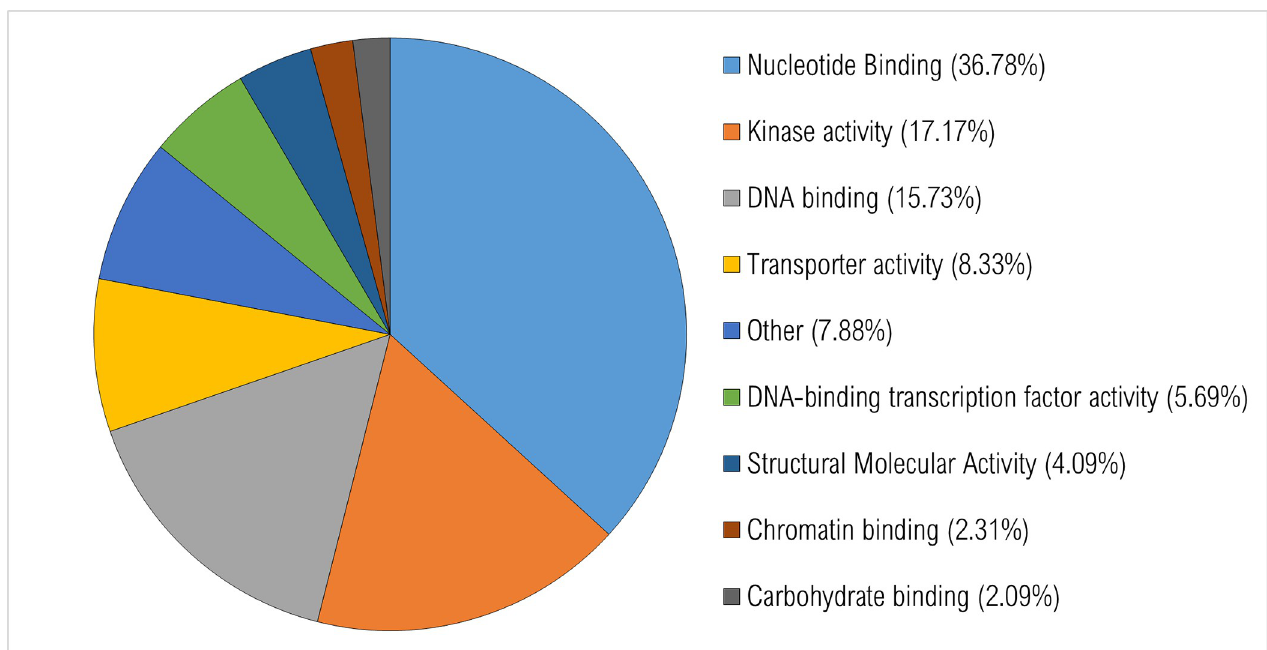
Fig 3. Percentage of transcripts in Populus tremuloides control samples. A total of 9953 transcripts were assigned ontology and grouped by molecular function using BLAST2GO. Categories under 2% were grouped together and classified as “other”.